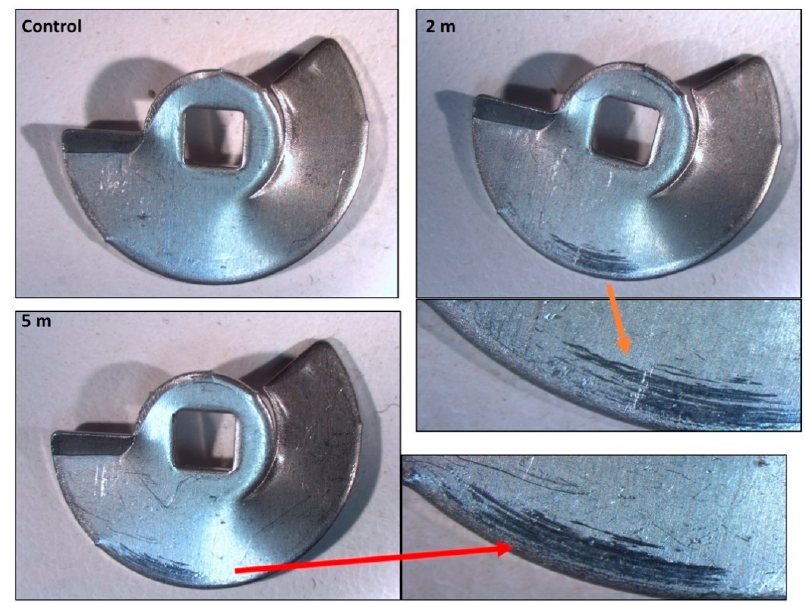
Figure 4. Reflected light microscopy of the Rigeneracons ® internal blade when unused (control), after 2 min of processing and after 5-min of processing. The unused blade showed no substantial scratch marks, however, as time of processing was increased, the scratch marks present on the outer rim increased in gross size (greatest after 5 min).